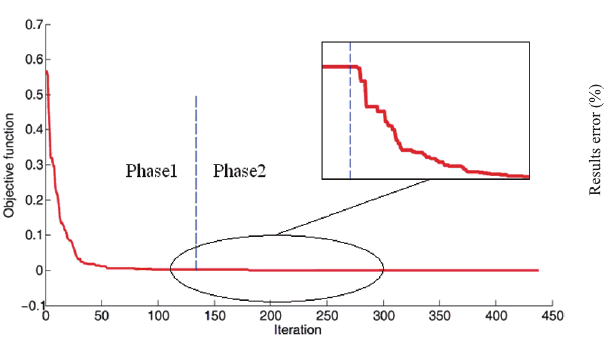
Fig. 18. Converge history of Belgian truss. Fig. 19. The results error of BB-BC in any phases for Belgian truss in Scenario